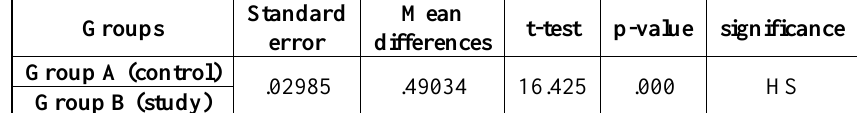
Table 8: t-test analysis of surface hardness test